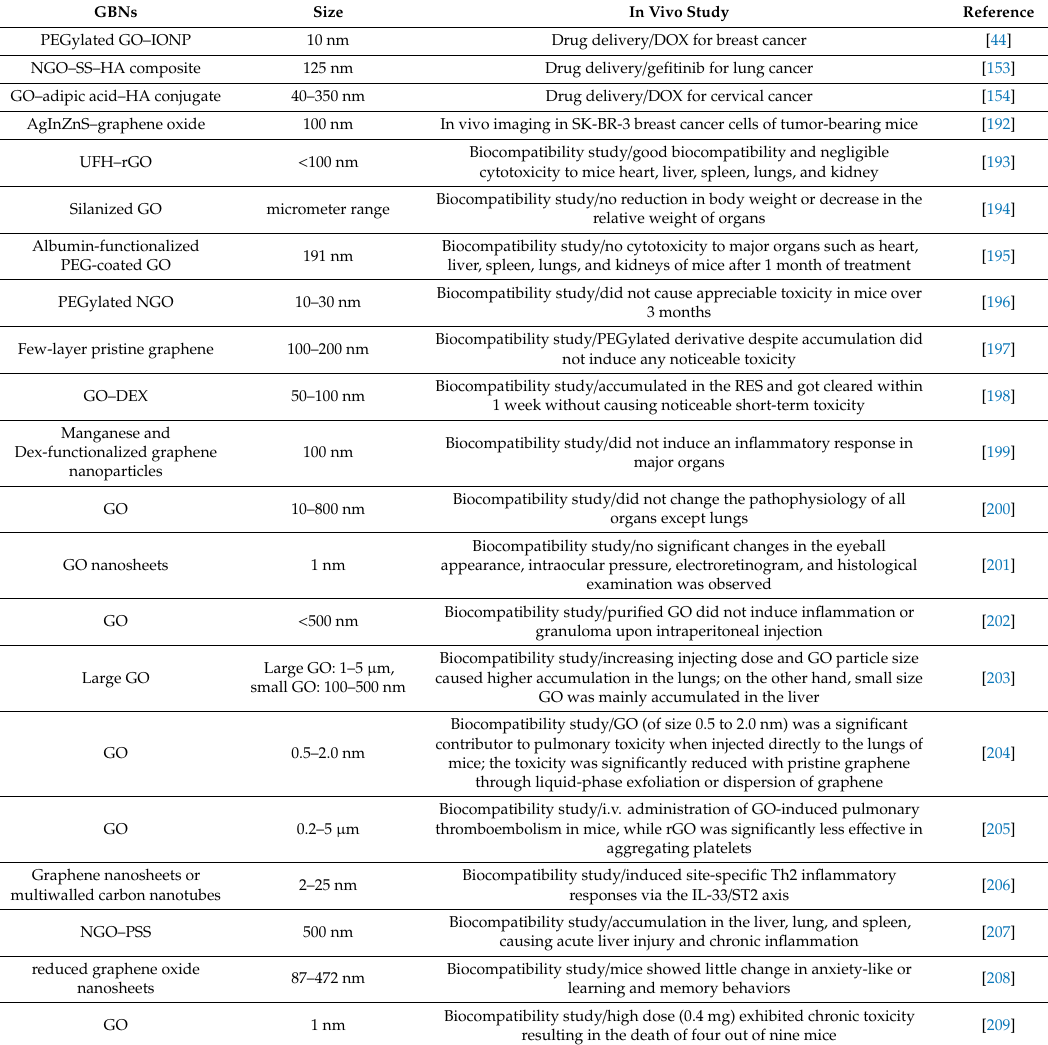
Table 6. In vivo studies on graphene-based nanomaterials